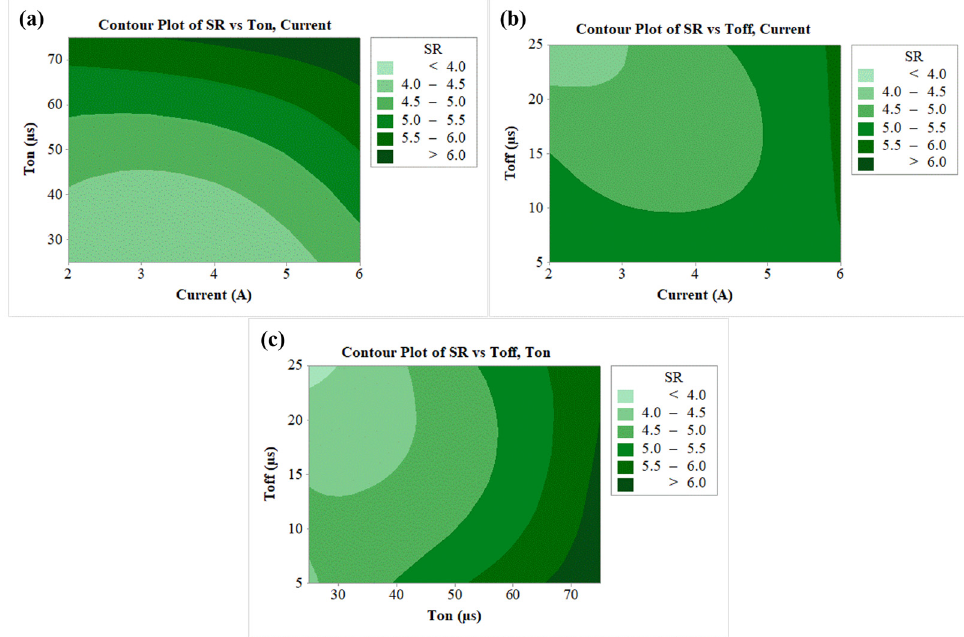
Figure 6. Contour plots for ( a ) SR vs T on , current, ( b ) SR vs T off , current, ( c ) SR vs T off , T on.